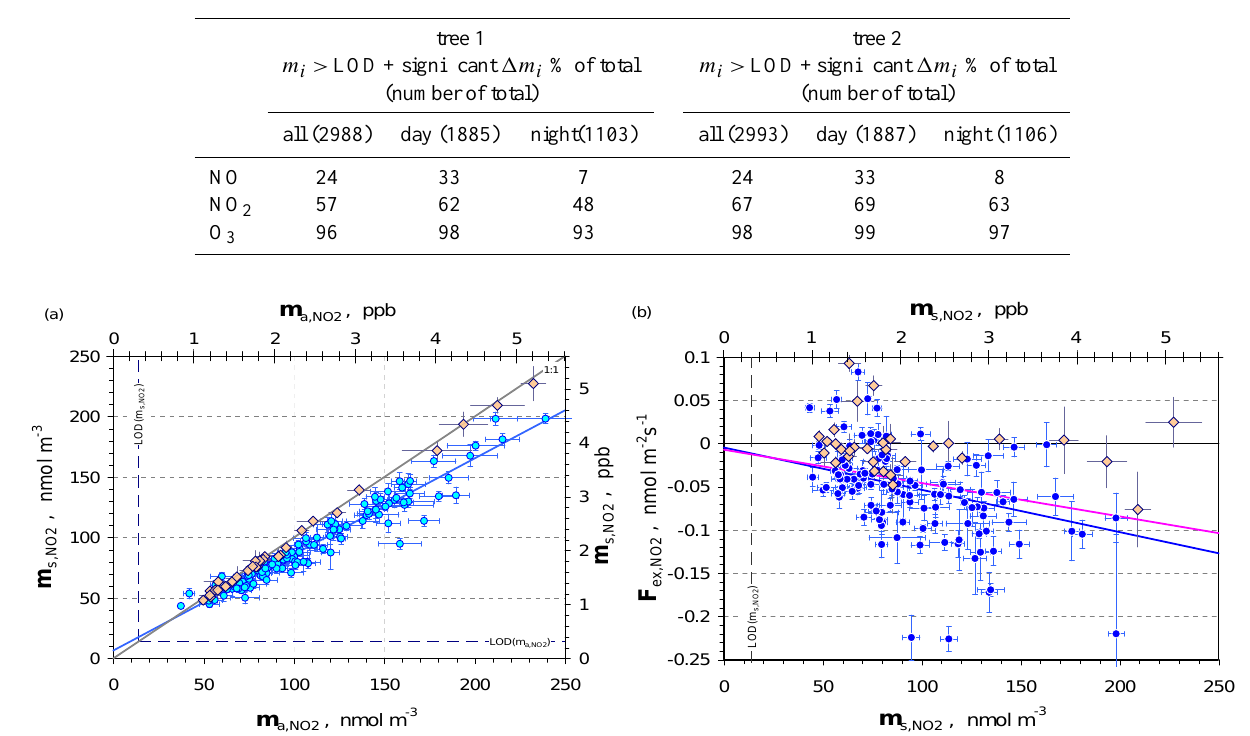
Figure 13. Field measurements: (a) NO 2 concentration measured at the outlet of the dynamic plant chamber ( m s,NO2 ) vs. NO 2 concentration measured at the inlet of the dynamic plant chamber ( m a,NO2 ). Light blue circles identify data pairs for significance of m NO2 = ( m a,NO2 m s,NO2 ) and reddish diamonds for those data pairs, which have to be rejected for non-significance of m NO2 = ( m a,NO2 m s,NO2 ). Blue line (considering blue circle data) is calculated according to bi-variate weighted linear least-squares fitting regression analysis (see Sect. 3.4.6). (b) NO 2 exchange flux density ( F ex,NO2 ) vs. NO 2 concentration measured at the outlet of the dynamic plant chamber ( m s,NO2 ). F ex,NO2 data were calculated according Eq. (1.1), their standard errors according to Eq.(14). Reddish diamonds stand for those F ex,NO2 data, which have to be rejected for non-significance of m NO2 = ( m a,NO2 m s,NO2 ). Blue line (considering blue circle data) and pink line (considering blue circle and reddish diamond data) are calculated according to Eq. (6.1).